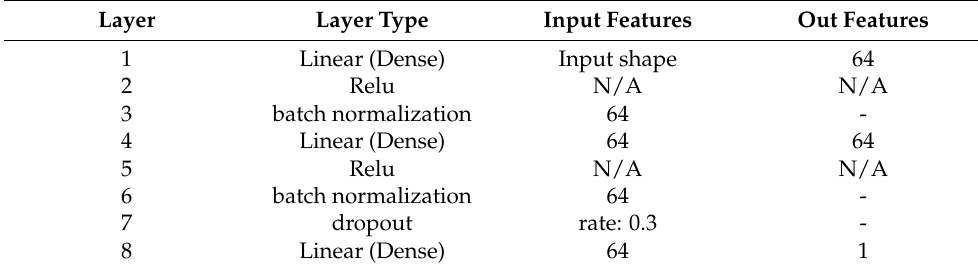
Table 2. The list of hyperparameters of the DNN model.